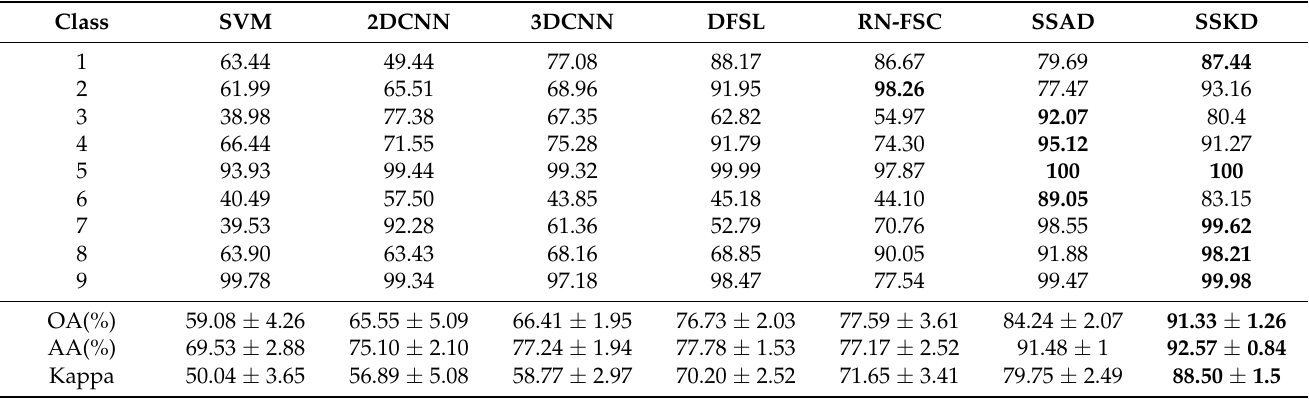
Table 6. The classification accuracy of several different methods on the UP dataset, with five labeled samples for each category. The best accuracy is shown in